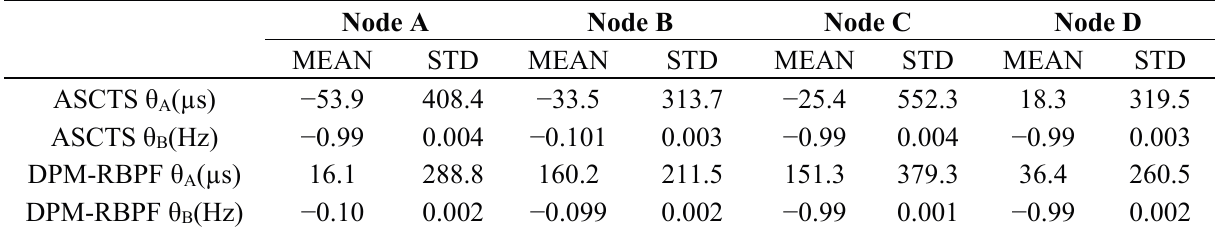
Table 2. Quantitative analysis of time synchronization in steady state (time interval 5 s).